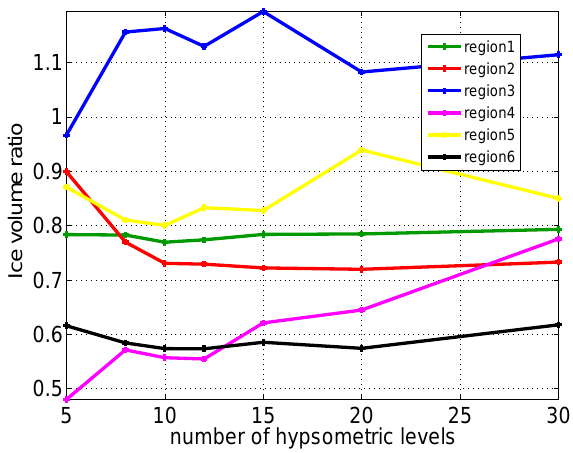
Figure 7. Average ice thickness root mean square error (RMSE) between the ISSM and the SG model for different topographic re- gions. Simulations are run over 2kyr using a constant precipitation rate of 1myr − 1 and a sea level temperature forcing of 0 ◦ C. Dif- ferent SG parameterizations are presented. Para 1 is the standard deviation of the topography parameterization (Eq. 6) and Para 2 the lowest hypsometric slope parameterization (Eq.